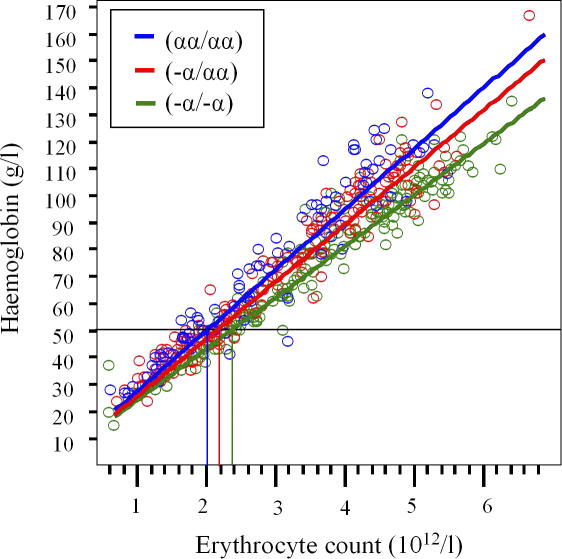
Genotype-Specific Erythrocyte Cutoffs for Severe Malarial AnaemiaData points represent haemoglobin concentration and erythrocyte count values for all children with acute malaria. Genotype-specific lines of best fit have been generated for the association of haemoglobin with erythrocyte count. The horizontal black line represents the cutoff for severe malarial anaemia (haemoglobin = 50 g/l). The coloured vertical lines represent the genotype-specific erythrocyte cutoffs for severe malarial anaemia based on a haemoglobin concentration of 50 g/l.